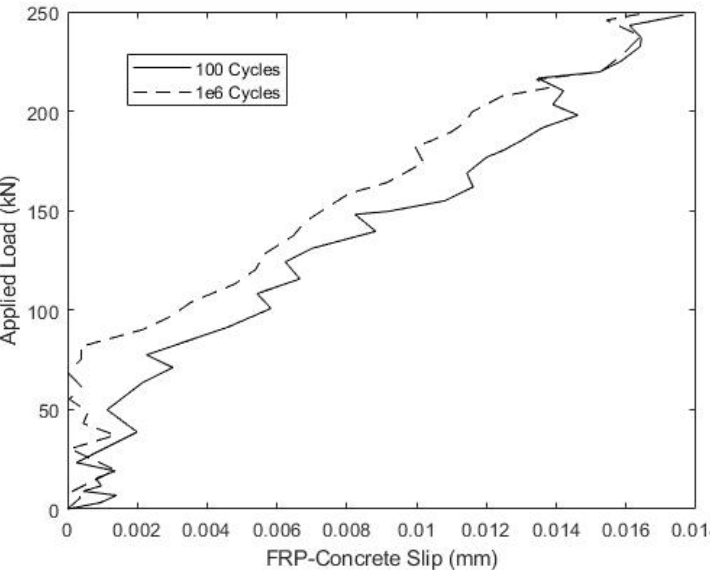
Figure 11. Beam B1 Service Load-Slip Behavior during Fatigue Cycling.